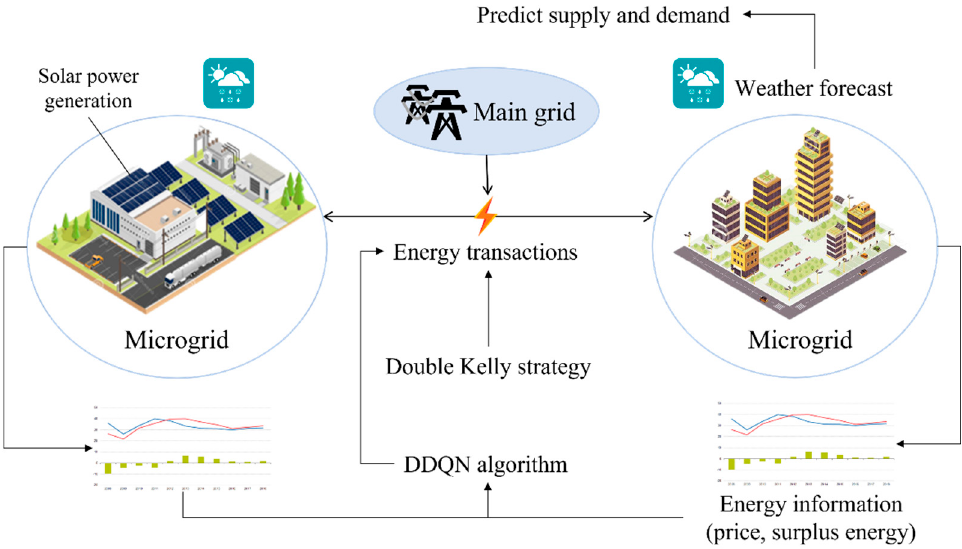
Figure 1. The proposed energy trading scheme based on the G2G model.